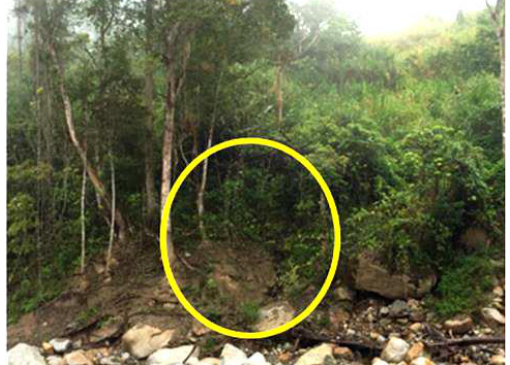
Figure 14. Evidence of groundwater flow marked by the yellow circle